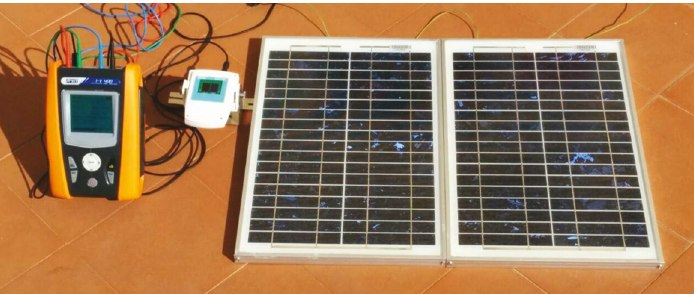
Figure 2: Two series-connected PVUs equipped with the IV Tracker. 26 September 2017, Aversa (CE), Italy. S = 600W/m 2 and ambient temperature T amb = 25 ° C